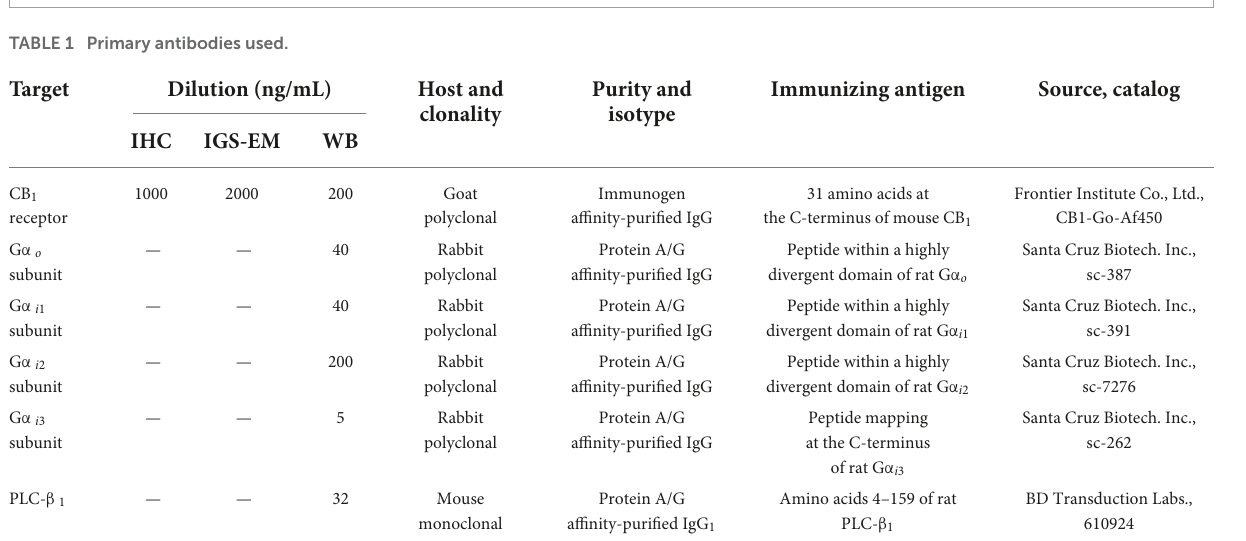
TABLE 1 Primary antibodies used. Target Dilution (ng/mL) Host and